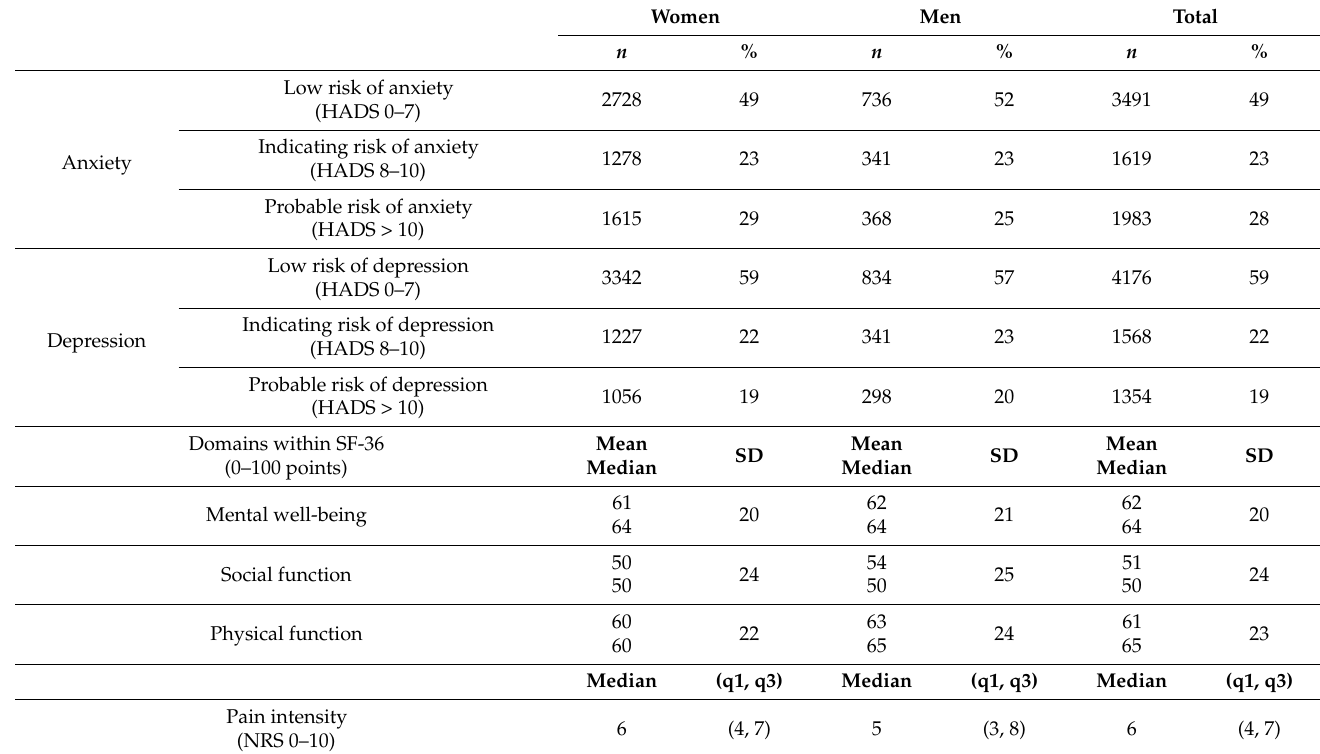
Table 5. Descriptive statistics on anxiety, depression, RAND-36 domains and pain intensity in the patient group after the IPRP. HADS = Hospital Anxiety and Depression Scale, NRS = numeric rating scale.